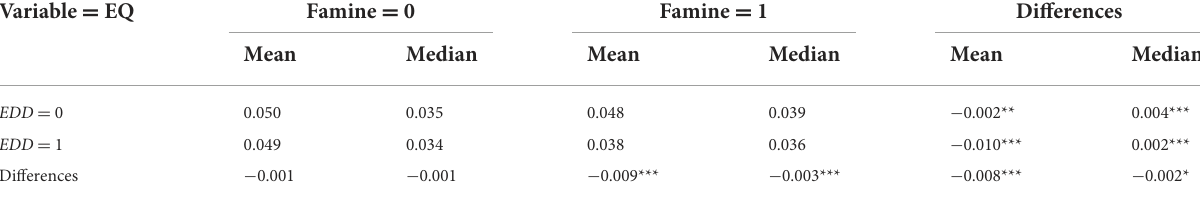
TABLE 3 Univariate analyses, grouped by whether the CEO experienced famine and the severity of the